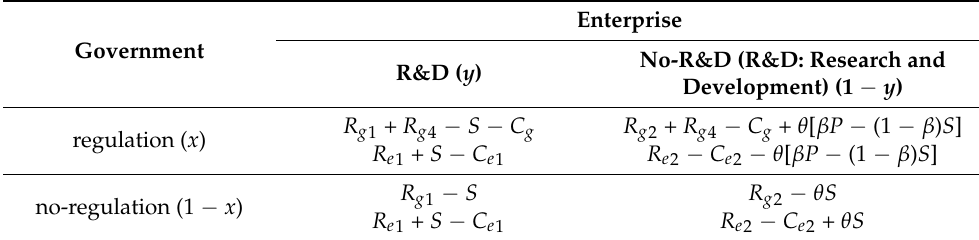
Table 5. Government–enterprise revenue